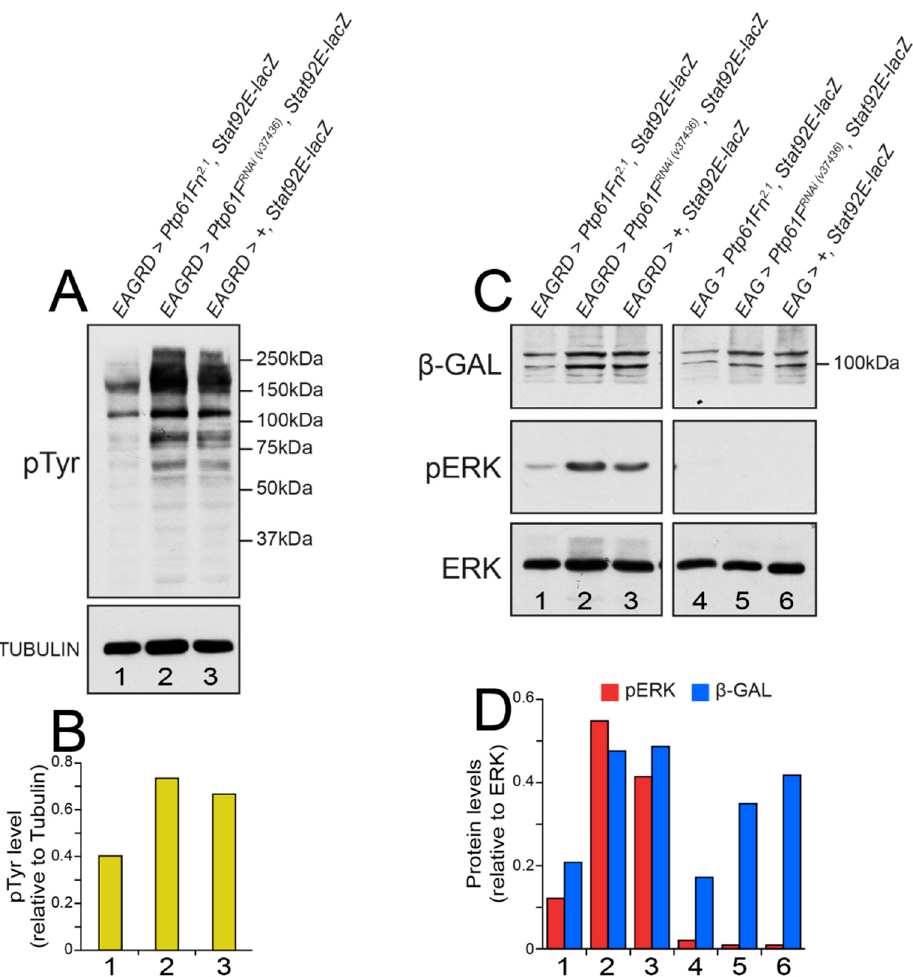
Figure 6. PTP61F represses tyrosine phosphorylation and JAK–STAT activity in activated RAS85D-driven polarity-impaired tumors. ( A ) Western blotting for the presence of tyrosine phosphorylated (pTyr) proteins and Tubulin protein levels in lysates from L3 eye-antennal imaginal disc tissues. Ptp61F RNAi or Ptp61Fn 2.1 was expressed throughout the eye-antennal tissue using the EAGRD system. ( B ) Quantification of pTyr levels. Relative to the Tubulin loading control, pTyr levels are higher in EAGRD samples expressing Ptp61F RNAi , and lower in those expressing Ptp61Fn 2.1 , relative to the con- trol. ( C ) Western blotting for β -gal (STAT92E-lacZ), phosphorylated and activated ERK (pERK), and